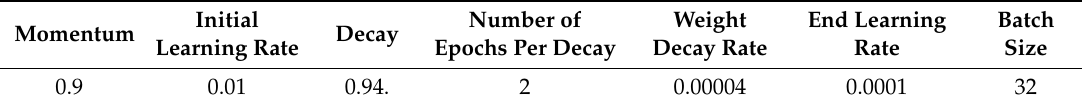
Table 5. Hyperparameters used in the fine tuning of Inception-Resnet-v2 network. Momentum